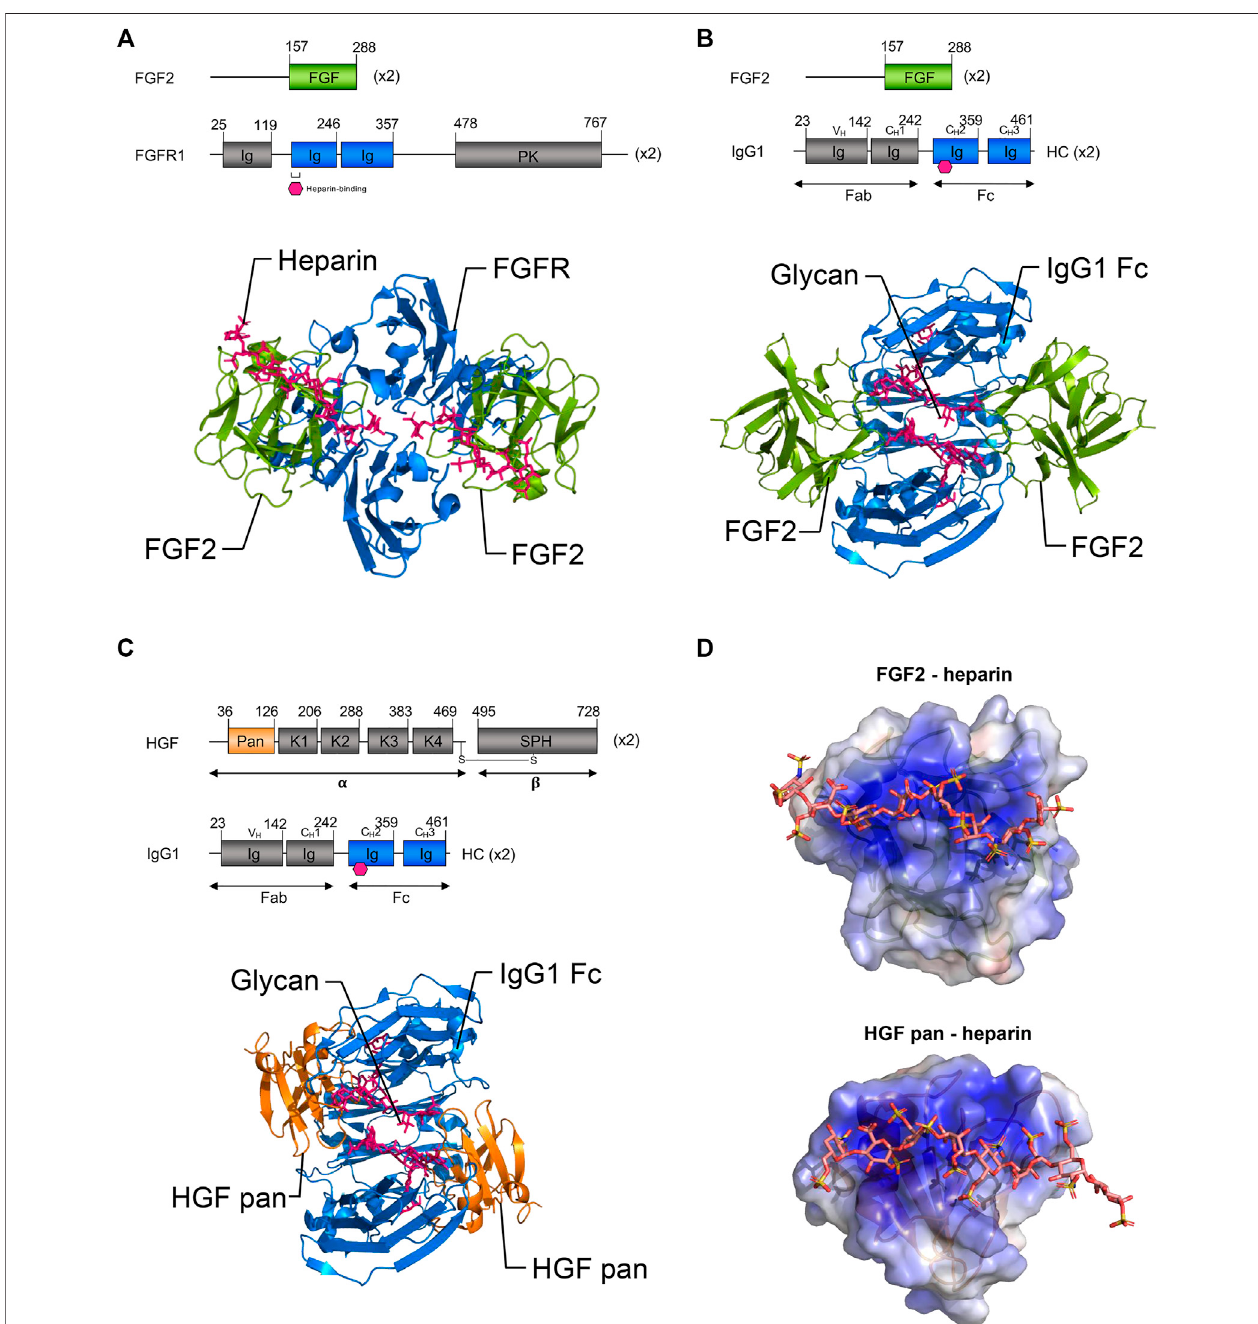
FIGURE5 | Three-dimensional modeling ofproposed growth factor: IgG complexes. (A) Top: Schematic representations of full-length FGF2 and FGFR1. Bottom: Ribbon representations of FGF2 (residues 158 – 286, green) bound to FGFR1 (blue) and heparin (pink) (published crystal structure, PDB ID 1FQ9). Note the binding of FGF2 proteins to FGFR1 occurs within immunoglobulin-like sub-domains. (B) Top: Schematic representations of the proposed binding of FGF2 to the IgG1 Fc domain. Bottom: Ribbon model of proposed binding of FGF2 (green) to the Fc domain of IgG1 (blue) within FGF2/IgG complexes. Note that based on similarities to FGF2: FGFR1binding,itispossiblethattheFcdomainofIgGmayaccommodatethebindingoftwoFGF2 ligands. (C) Top:SchematicrepresentationsoftheHGFpandomain and IgG1. Bottom: Ribbon model of proposed binding of HGF pan domain (orange) to the Fc domain of IgG1 (blue) in HGF/IgG complexes. Note that it is also possible that the Fc domain of IgG may accommodate the binding of two HGF ligands. (B,C) Pink hexagon (top) and sticks (bottom) = glycosylation. (D) Electrostatic surface potential models of FGF2 and HGF pan domain bound to heparin (sticks) (PDB IDs 1FQ9 and 1GMO, respectively). Note growth factors have heparin binding domains that are thought to bind within immunoglobulin-like domains of their respective RTK receptors. Basic patches (blue surface) may be involved in the binding of FGF2 and HGFinthedescribedcomplexes. PK, protein kinase;HC,heavychain; K1 – K4, Kringledomains; SPH,serineproteasehomology domain; alpha, HGFalphachain; beta, HGF beta chain. Gray, domains not shown in ribbon